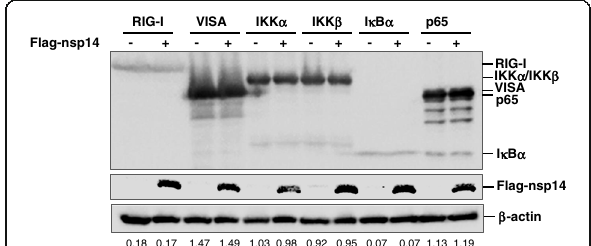
Fig. 4 PEDV nsp14 did not inhibit protein expression of various components of NF- κ B pathway. HEK293T cells were transfected with constructs expressing HA-tagged RIG-I, VISA, IKK α , IKK β , I κ B α or p65 along with vector plasmids or Flag-nsp10 expression plasmids. At 24 hpt, cell lysates were prepared for Western blotting analysis with the indicated antibodies. The relative abundance of the detected proteins was determined by densitometric analysis using ImageJ software